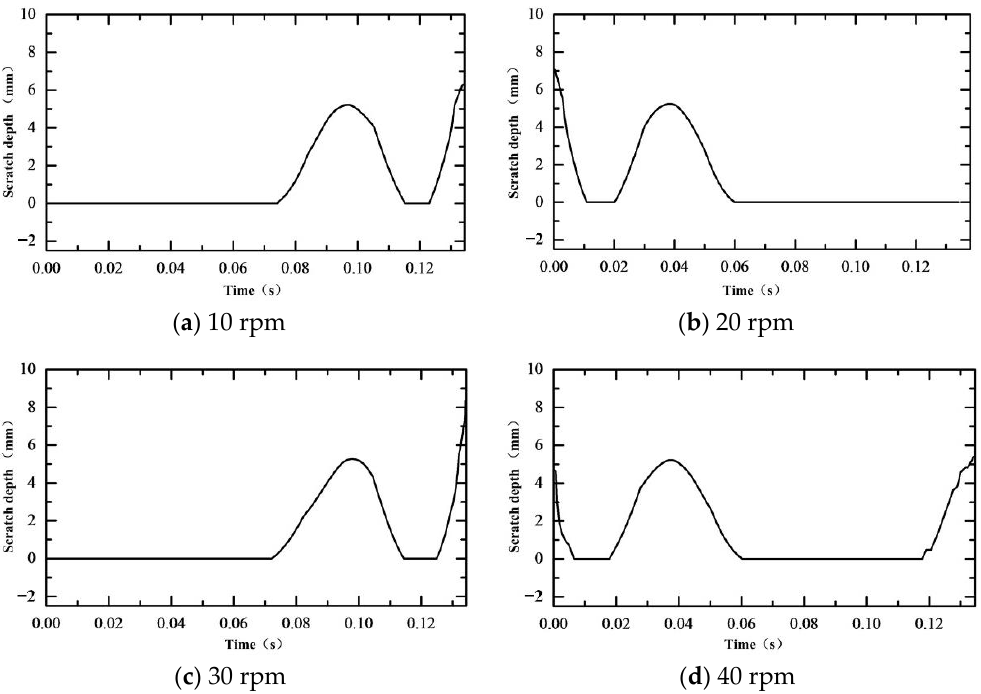
Figure 25. Scratch damage depth with different magnetic field speeds.